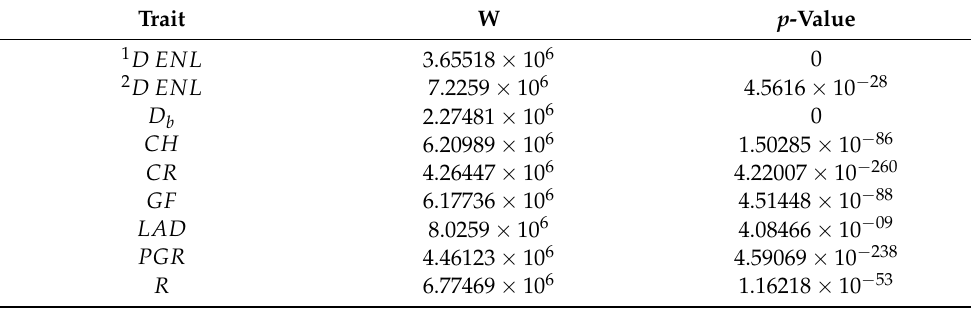
Table A9. Overview of Wilcoxon test results.